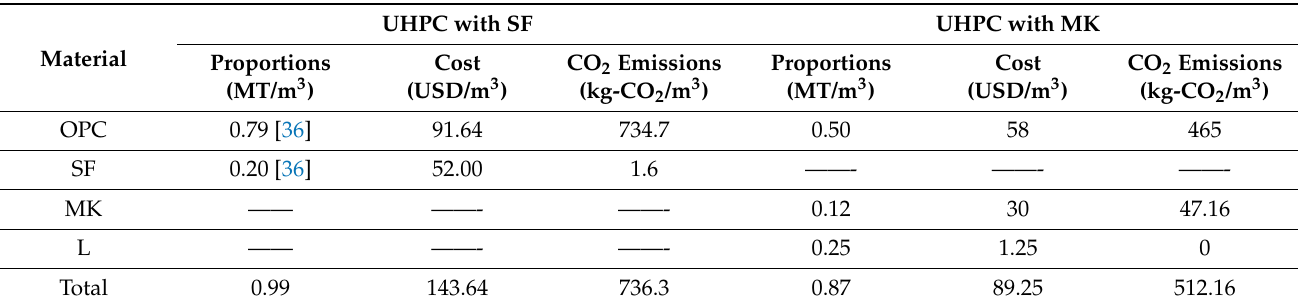
Table 6. Comparison of cost and CO 2 emission attributed to the fine powder fraction in UHPC’s with SF or MK and